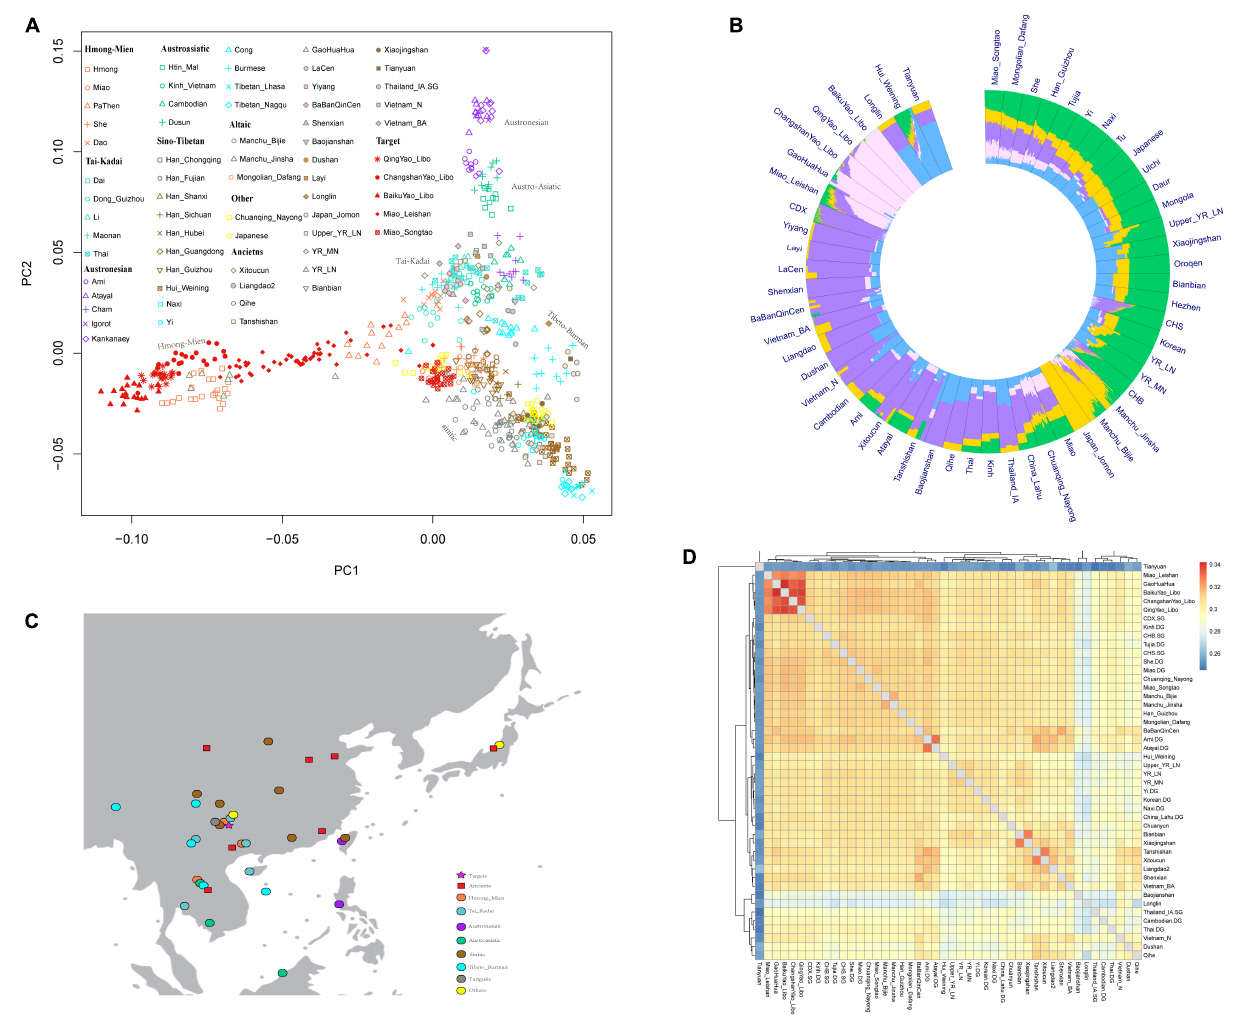
FIGURE 1 | Genetic structure and population affinity of Hmong-Mien-speaking populations and their neighbors. (A) Principal component analysis among modern and ancient East Asians. Ancient individuals were projected onto modern backgrounds. (B) Model-based ADMIXTURE results among Chinese modern and ancient populations. (C) The geographical position of our studied populations and referenced populations. (D) Sharing genetic drift between Hmong-Mien people and other reference